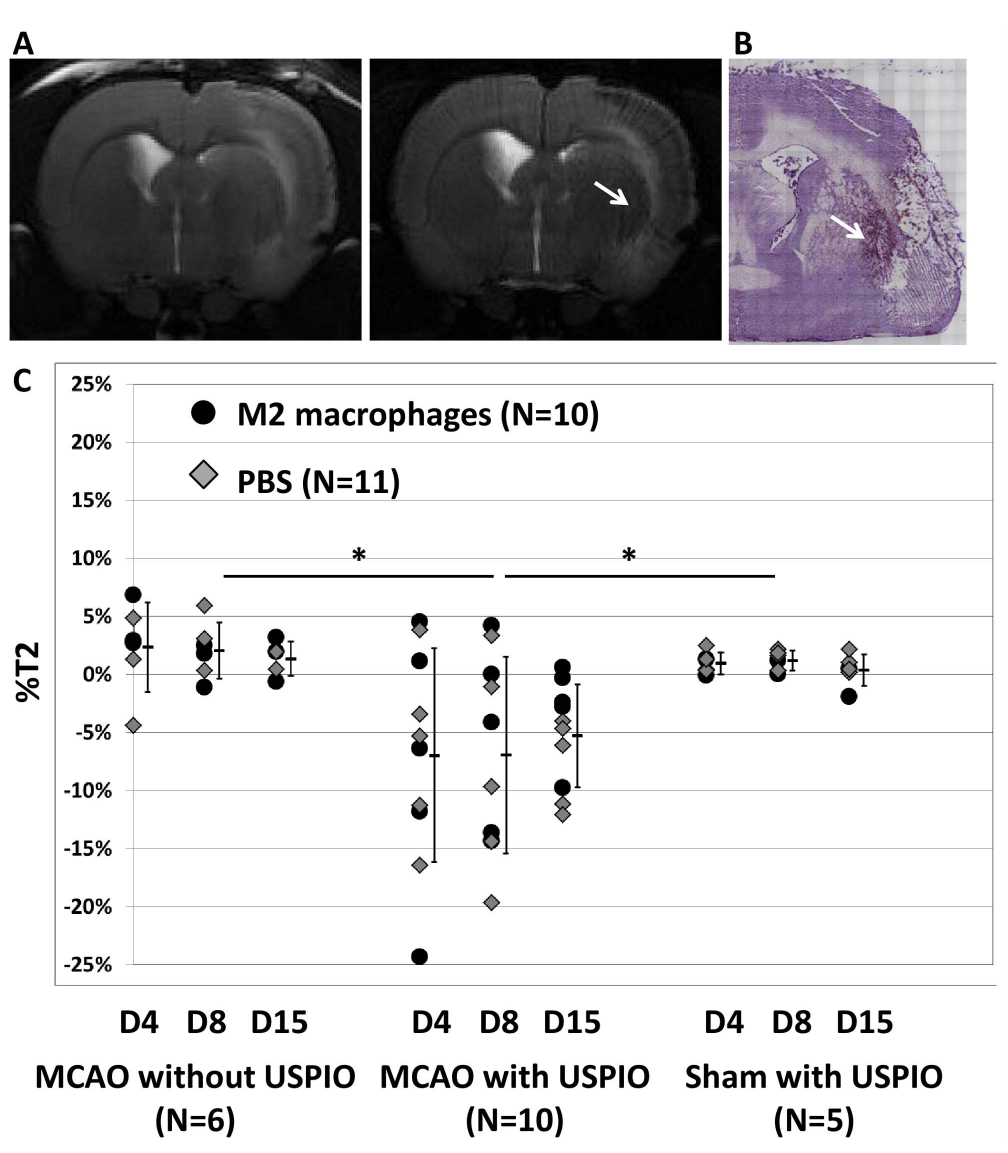
Figure 6. M2 macrophages do not reduce cerebral USPIO uptake after ischemic stroke. A- Typical T2-weighted images obtained before and 24 h after intravenous USPIO injection. The arrow shows the slight hyposignal detected in the perilesional area. B- Abundant ED-1 + cells were detected at the same location (arrow). C- Quantification of T2 difference between ipsilateral and contralateral hemisphere (%T2) showed that the T2 drop in the perilesional area was specific to tMCAO rats injected with USPIO (analysis of variance for repeated measures, *p , 0.01). However, no effect of M2 treatment on T2 changes was found (analysis of variance for repeated measures, N=5 in each group, p=0.523).